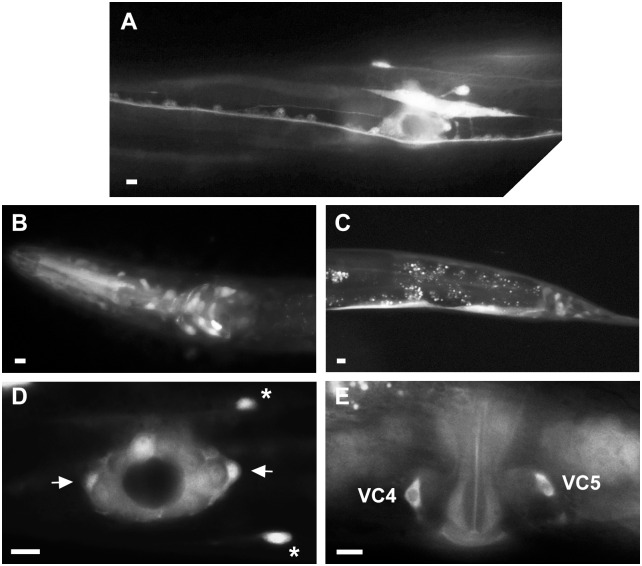
fntb-1 is expressed in VC4 and VC5 neurons.(A) Pfntb-1::GFP expression in the mid-body region of an L4 hermaphrodite. Pfntb-1::GFP expression in the head (B) and tail (C) region of an L4 hermaphrodite. The fntb-1 promoter is active in neurons, vulval and rectal epithelial cells and in muscle cells. (D) Pfntb-1::GFP transcriptional activity in VC4 and VC5 (arrows), HSNs (asterisks) and vulval epithelial cells at the mid-L4 stage vulval region. (E) Adult vulval region showing FNTB-1::GFP protein fusion predominantly localized to the cytoplasm of VC4 and VC5 neurons. Panels A, D and E show ventral views. Panels B and C show side views. Scale bars, 10μm.